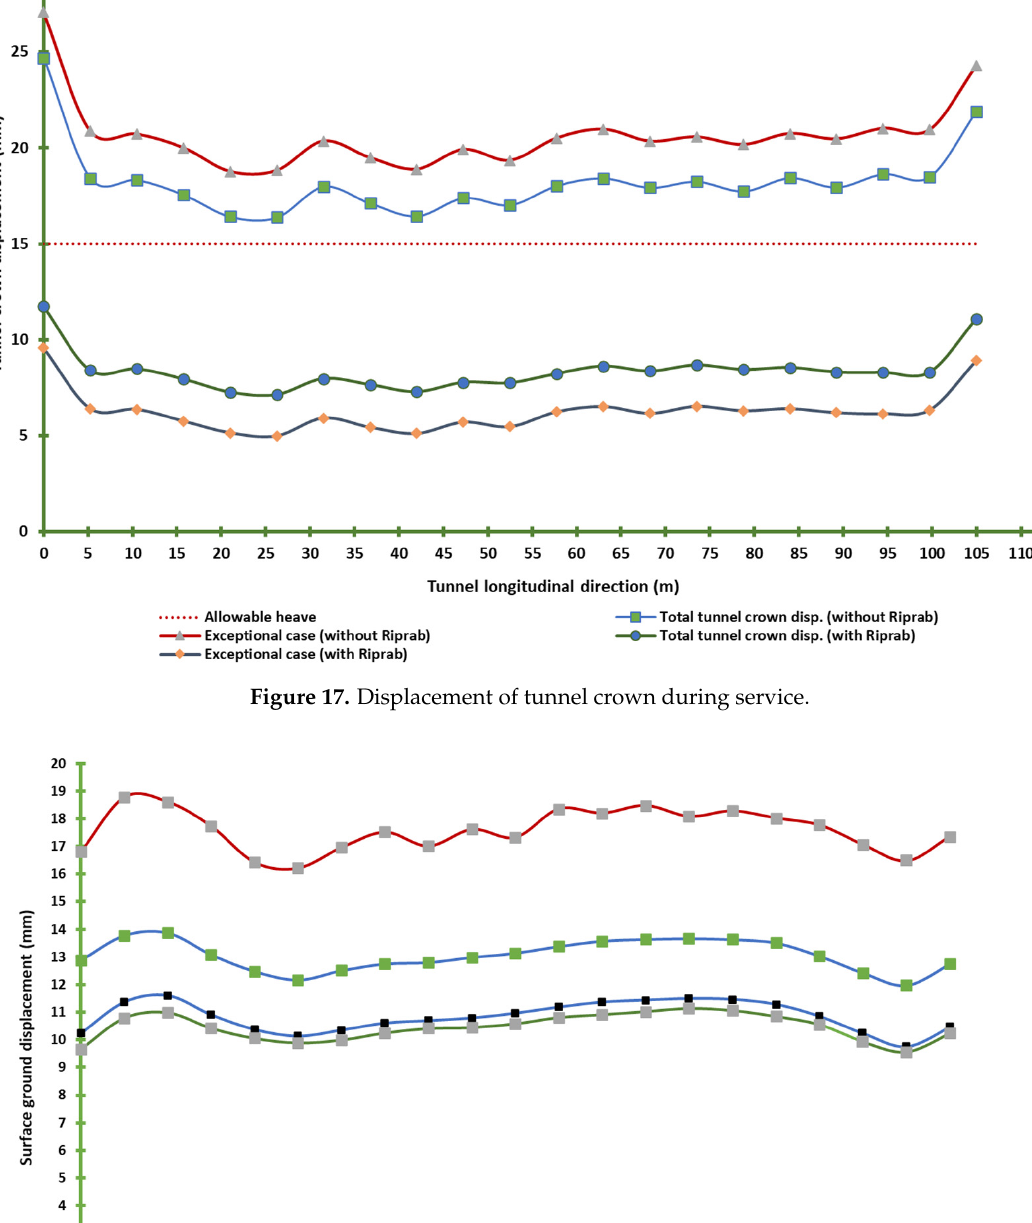
16 of 21 Figure 16. Displacement of tunnel crown during construction.